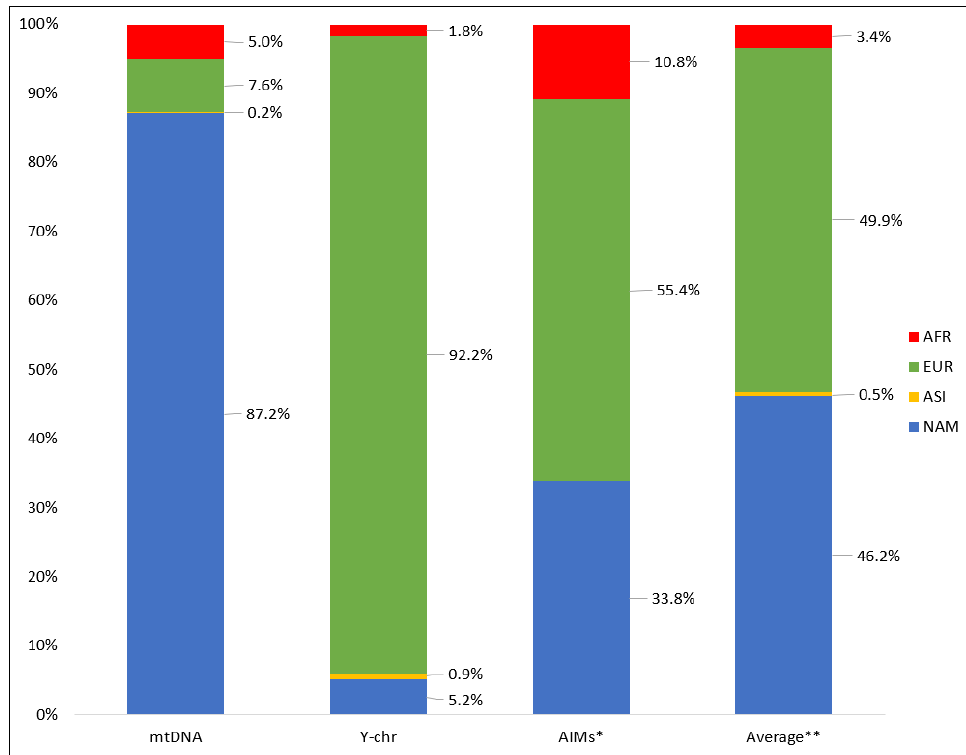
Figure 2. Ancestry proportions obtained with mtDNA ( n = 537), Y chromosome ( n = 463), 46 AIM-InDels ( n = 422), and average of mtDNA and Y chromosome. AFR—African; EUR—European; ASI—Asian; NAM—Native American. * Ancestry estimates calculated for k=3. ** Average of mtDNA and Y chromosome ancestries.